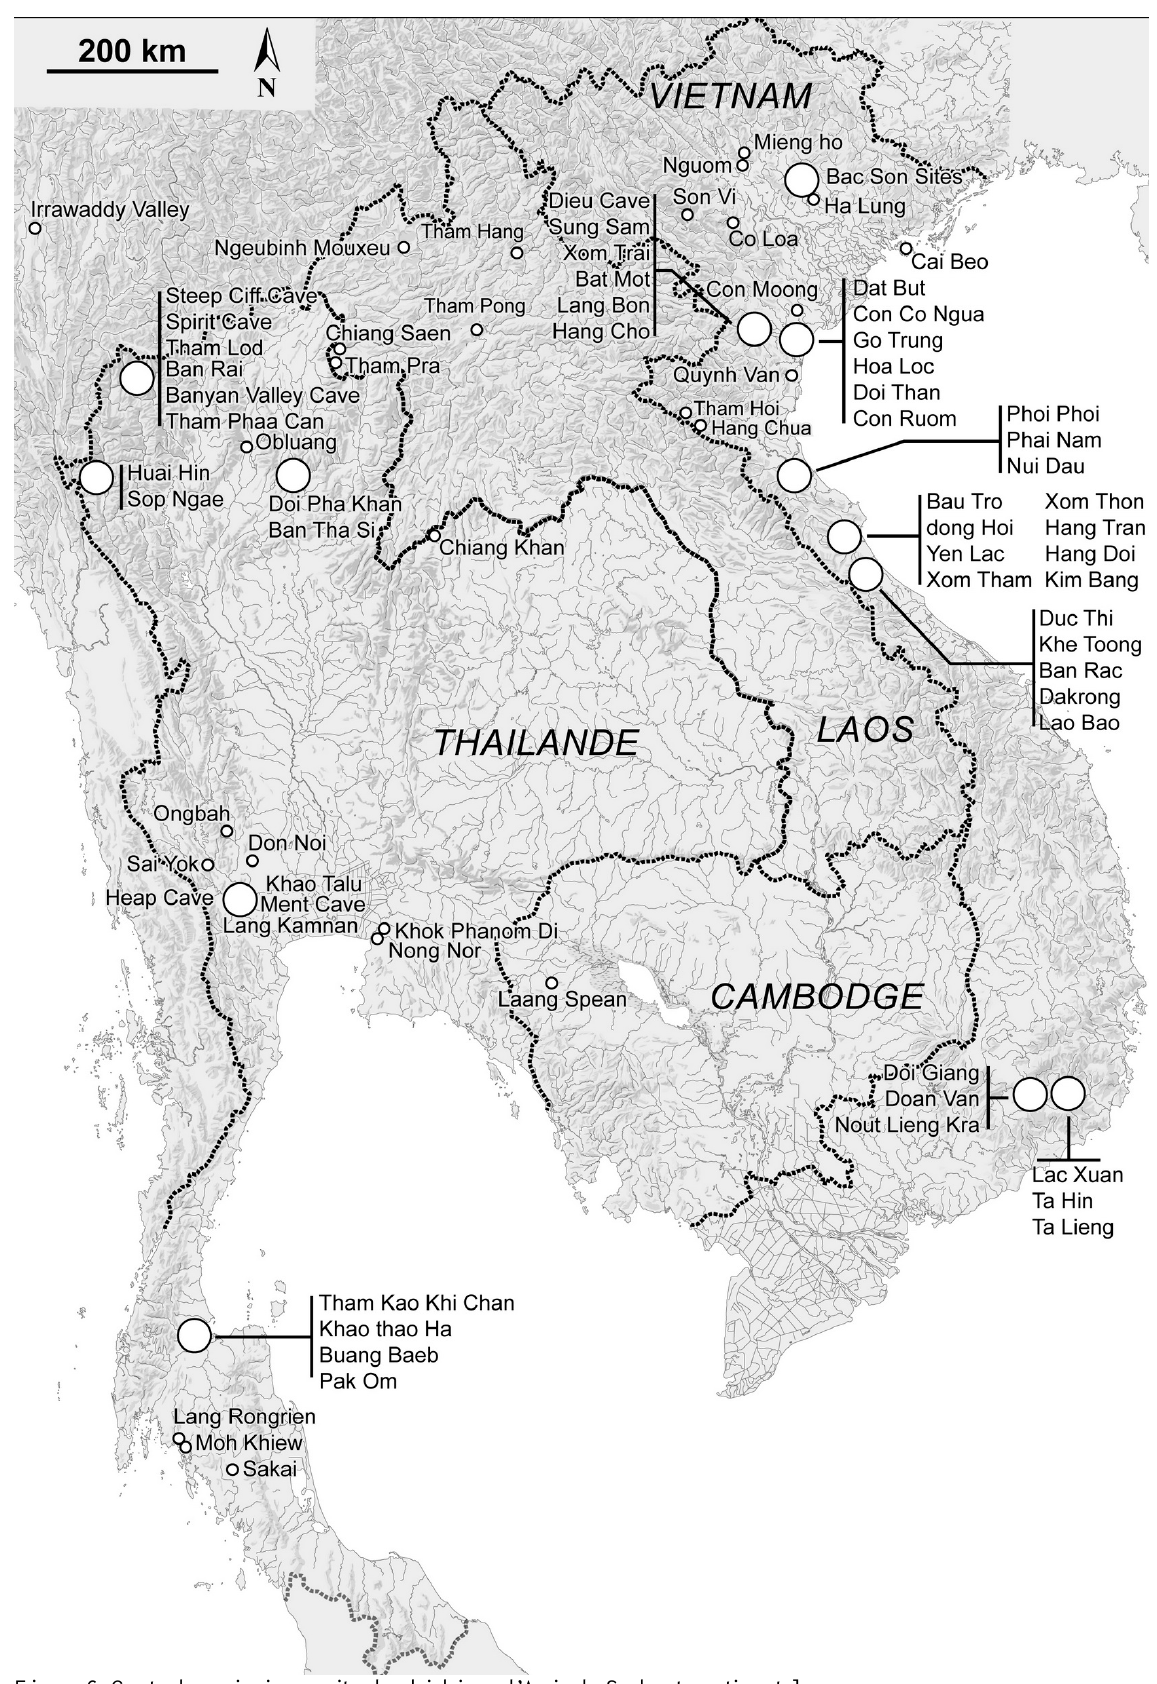
Figure 6. Carte des principaux sites hoabinhiens d’Asie du Sud-est continentale. Figure 6. Map of the major Hoabinhian sites in Southeast Asia